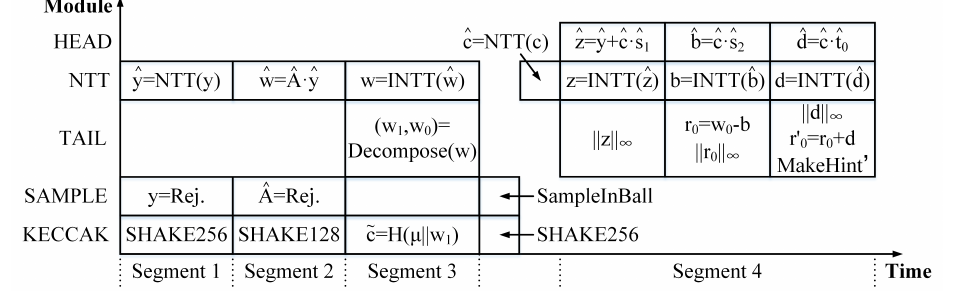
Figure 3: Segmented pipelined processing of Sign